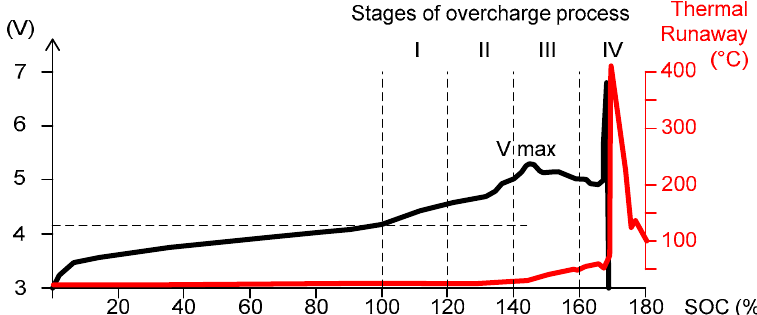
Figure 15. Li-9on cell charging process and stages of overcharge states [38,39]. The measurement setup, shown in Figure 16, consists of a universal Li-ion charger (leftmost), the JUNS iCharger 1010B+, and current clamps (middle image) with a clean contact surface for achieving the lowest possible clamp contact resistance. Furthermore, the same figure (rightmost) shows the contents of the disassembled e-bike battery pack without 2 pack-origin defective cells and with 10 replacement cells acquired from the used laptop battery packs. Replacement cells from the used battery packs were originally planned to be a replacement source and eventually to replace all defective cells of the initial e-bike battery pack [40]. Among newly sourced cells, we found two battery cells that matched in appearance and labeled exactly as those in the original e-bike battery pack, so we placed them at cell positions 1 and 3 in the initial battery pack layout. With that substitution, the battery pack was restored back to the operational state, thus making the further investigation and analysis possible to continue and the battery pack usable again to some extent.